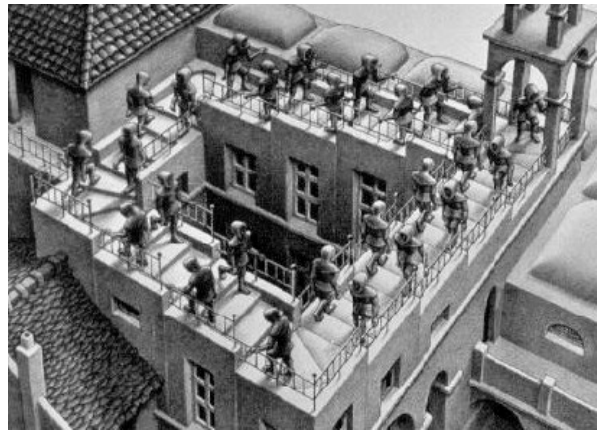
Figure 5. M. C. Escher, Klimmen en Dalen , 1960, detail.